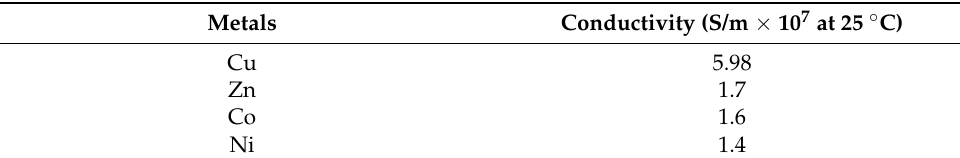
Table 2. Conductivity of Cu, Zn, Co, and Ni [40,41].